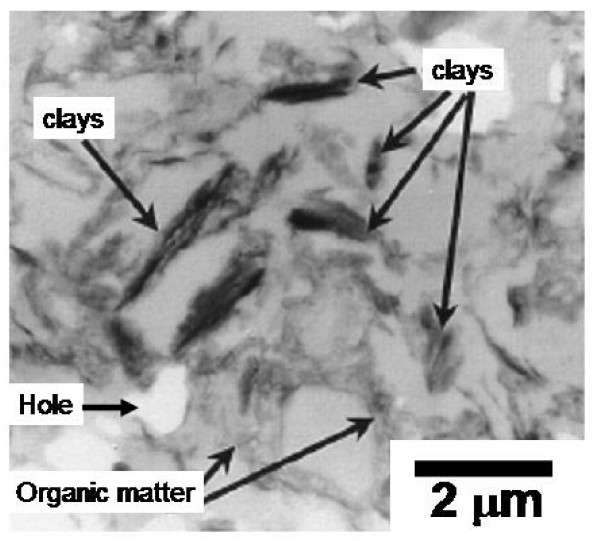
Transmission electron micrograph (TEM) image of resin-embedded, ultrathin-section of fine-grained sediment from the Bay of St. Louis, Mississippi. The fabric is characteristically porous, as the light grey color indicates pore space, now replaced by resin. Dark features represent clay mineral particles (domains) and heavy metal-stained organic matter. Bright areas are thin sectioning artifacts (i.e., holes after mineral grains were plucked out during thin-sectioning.)